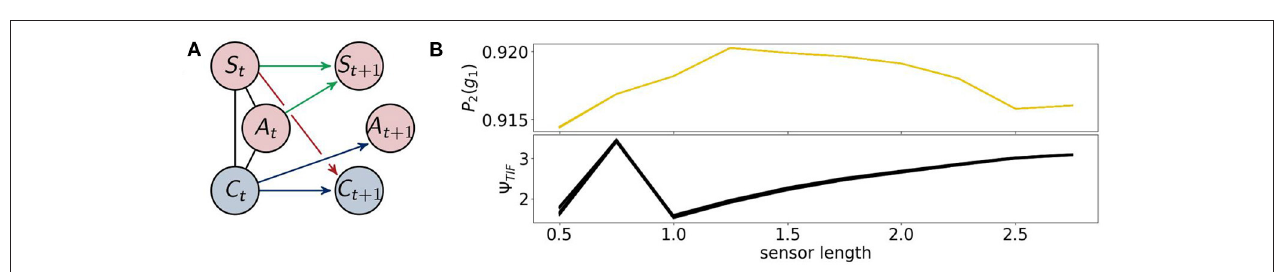
Frontiers in Psychology |